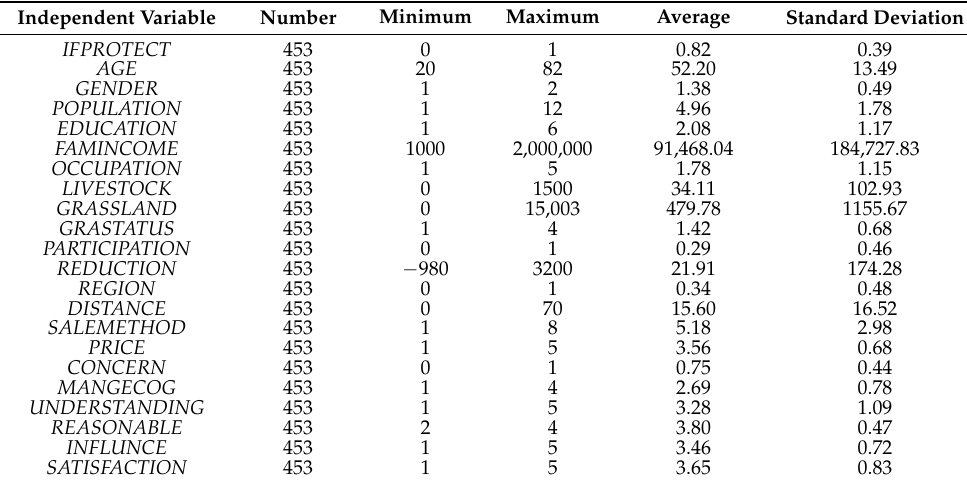
Table 2. Variable description statistics of the herders’ willingness to protect